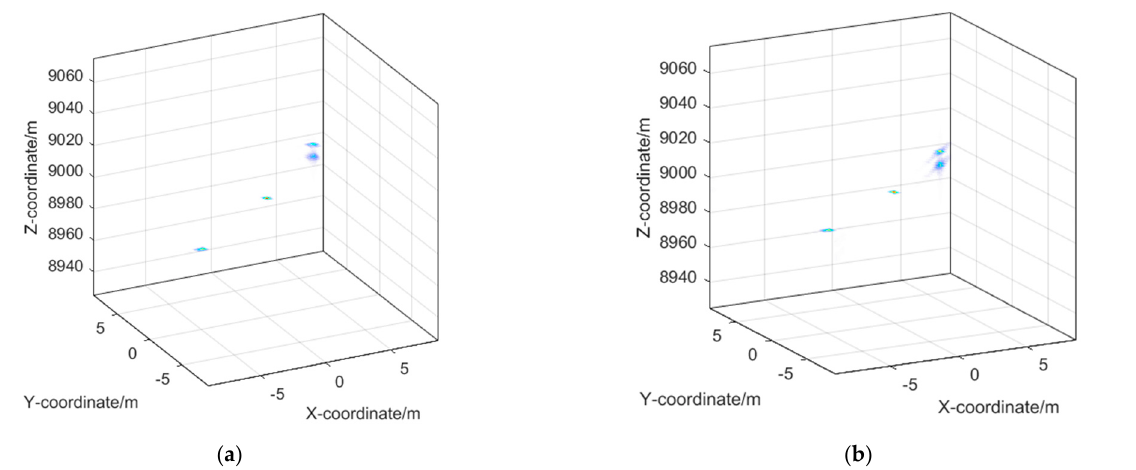
Figure 20. Sparse array 3D imaging results with two sparse imaging algorithms. ( a ) Sparse array imaging result with basis pursuit algorithm. ( b ) Sparse array imaging result with OMP algorithm.